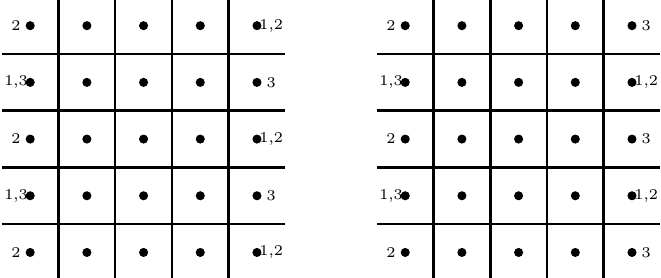
Figure 25 . Left panel: anti-correlated boundary condition A 6 = . Right panel: correlated boundary condition C 6 = .